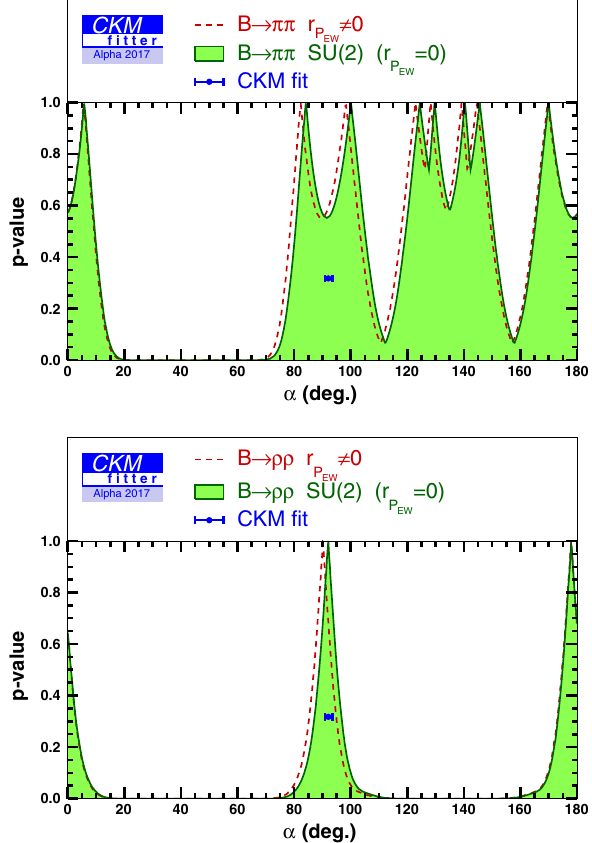
Fig. 12 SU ( 2 ) constraint on α including an electroweak penguin con- tributiongivenbyEq.(47)( reddashedline )andneglectingthispenguin contribution ( green shaded area ) for B → ππ ( top ) and B → ρρ ( bot- tom